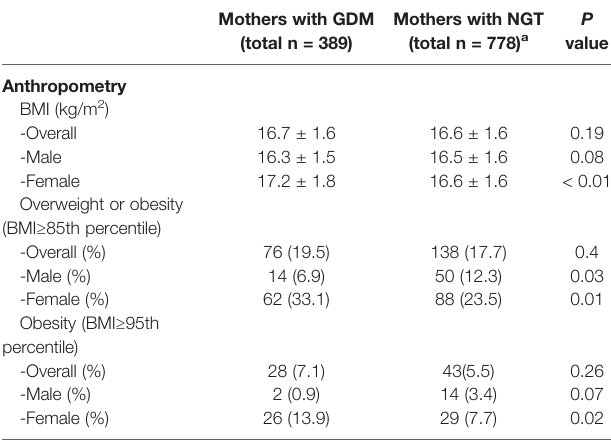
a Data are given as n (%) or mean ± SD. 404males in NGT group and 202 in GDM group whereas 374 females in NGT group and 187 in GDM group. GDM, gestational diabetes mellitus; NGT, normal glucose tolerance; BMI, body mass index.